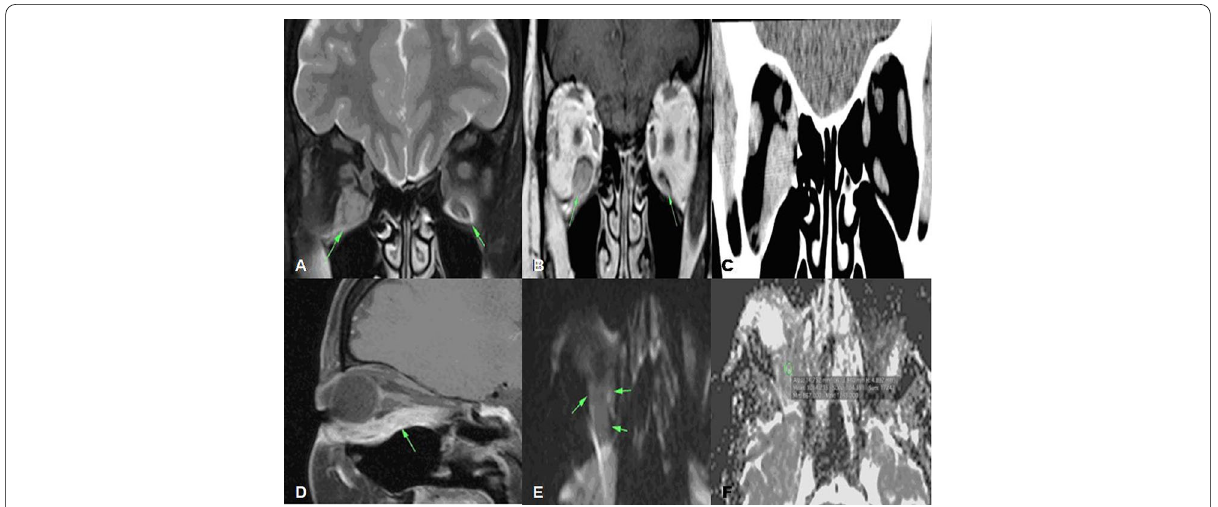
Fig. 6 A 34-year-old male patient with acute onset of right-sided dull aching orbital pain and limited orbital movement Coronal T2WI and T1WI images A , B show enlarged right inferior and lateral recti muscles displaying T1 and T2 isointense signal with minor similar changes involving the left inferior rectus muscle. Complementary non-enhanced CT coronal image C shows bulky right inferior muscle and to lesser extent right lateral rectus muscle. Contrast-enhanced sagittal T1 fat-saturated image D shows marked contrast enhancement of inferior rectus muscle bulk. No diffusion-weighted restriction seen on DWI (b 500 ) ( E ) and ADC ( F ). The ADC value is 1.1 10 − 3 mm 2 /sec. Right-sided orbital inflammatory × pseudotumor, Myositic type; responded well 2 weeks after therapeutic trial with corticosteroids